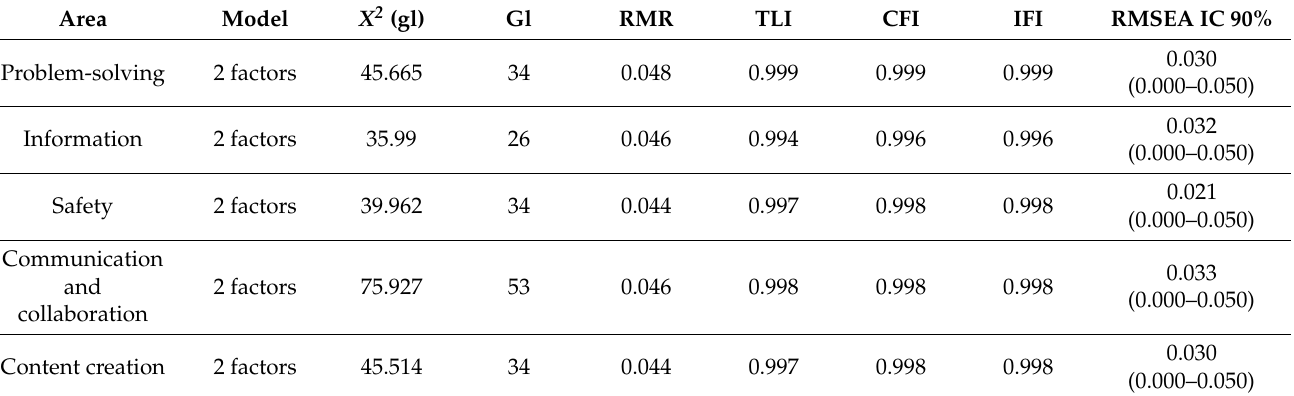
Table 9. Goodness-of-fit indices of the model (CFA).